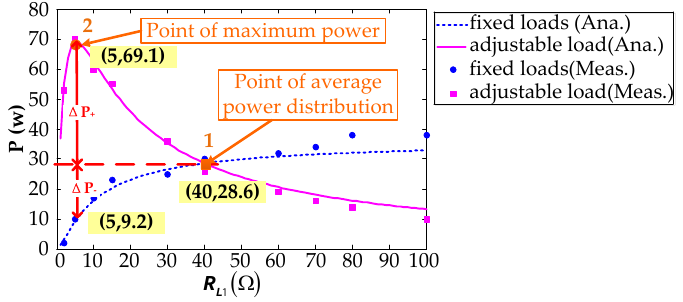
Figure 11. Receiving power versus adjustable loads when N = 3.